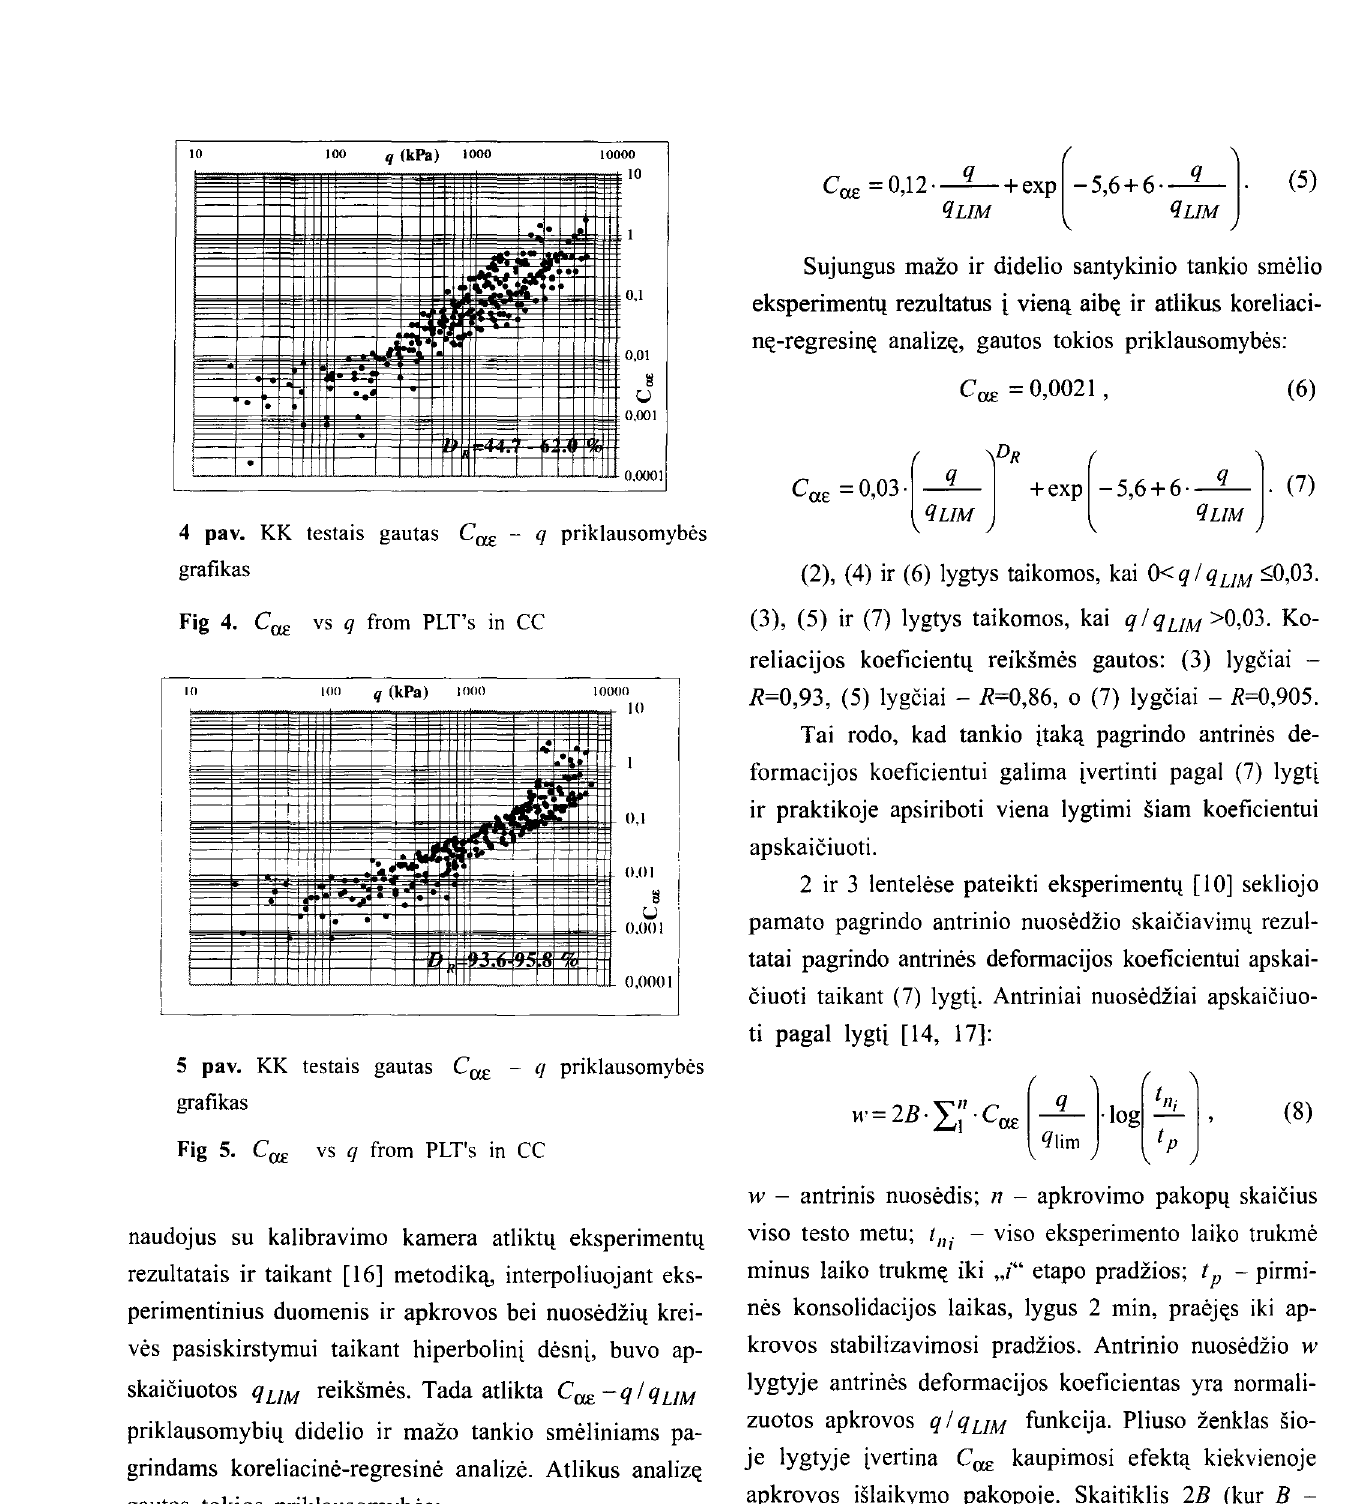
Fig 4. Cru: vs q from PLT's in CC